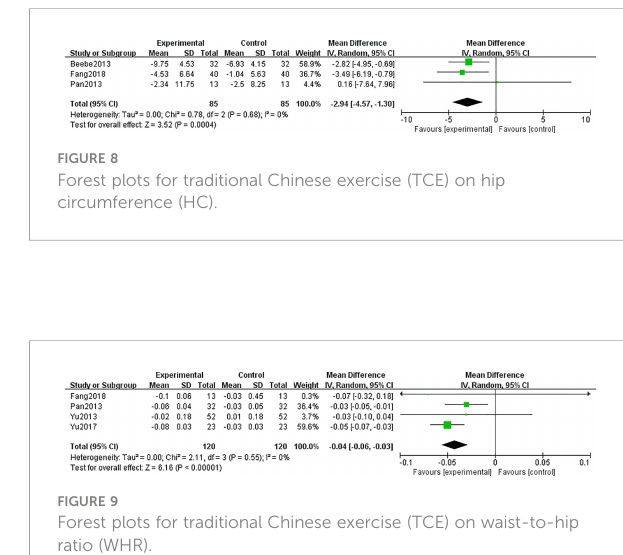
FIGURE 9 Forest plots for traditional Chinese exercise (TCE) on waist-to-hip ratio (WHR).